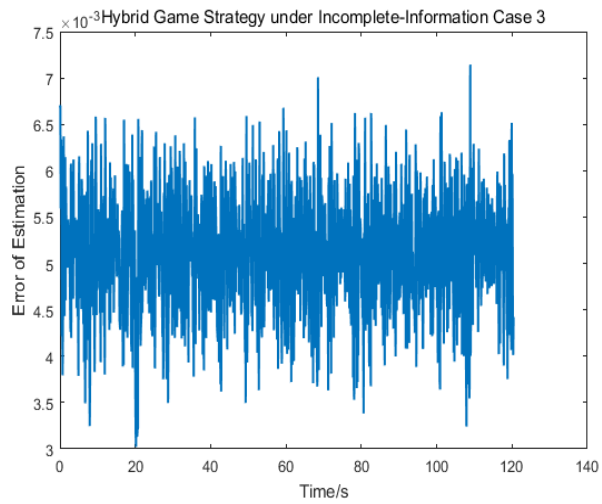
U . Figure 21. Error estimation of U E . E U . E